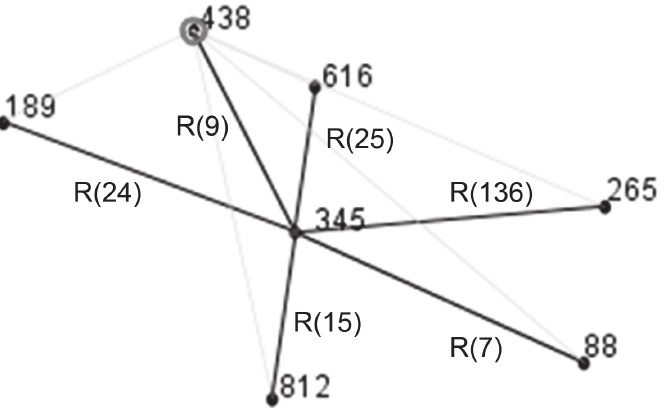
Fig 1. V . parahaemolyticus “ snapshot ” of CC345 obtained using eBURST v3. Other CCs were defined using stringent criteria (6/7 shared alleles) (Figure B in S1 File). Among those groups or CCs, ST345 was identified as the predicted clonal ancestor of CC345. STs that are SLV of each other are shown connected by lines (black). DLV STs are shown as connected light gray lines. CC — Clonal Complex. R- Recombination event and the number of SNPs between ST345 (founder) and the other STs are between brackets. All the differences were located at the recA allele, except for ST812 that were located at the gyrB allele.